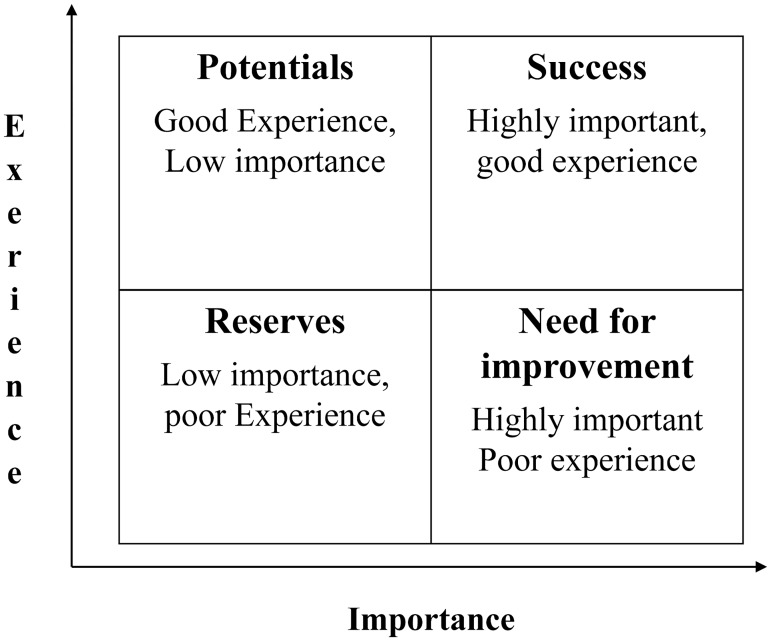
Correlation grid.